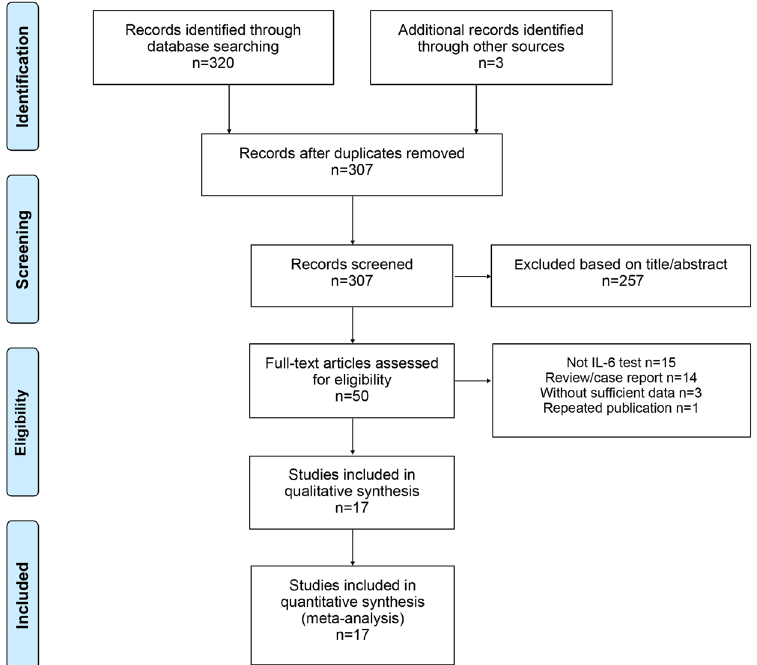
Figure 1. Flow diagram for study selection.